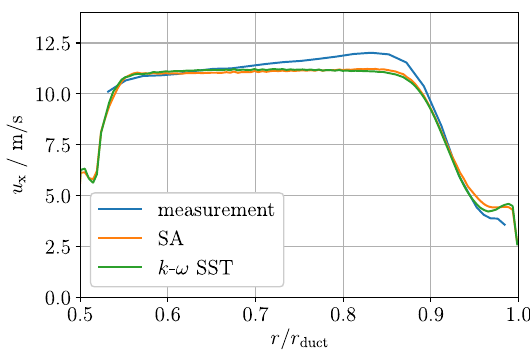
Figure 9. Time averaged velocity in axial direction on the pressure